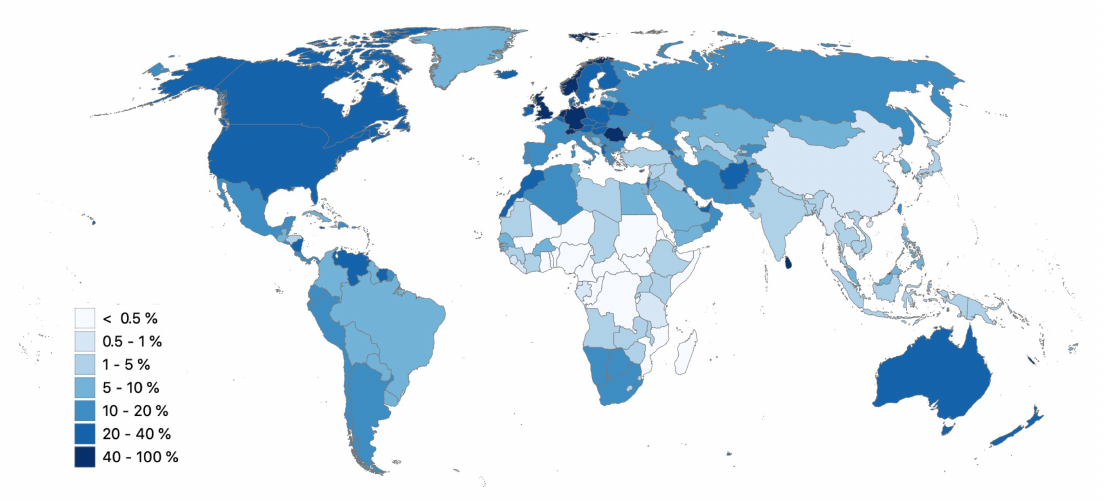
Figure 1. Proportion of the total length of all roads with maximum speed information in OpenStreetMap (OSM) ( maxspeed tag) per country (only road classes in Table 1). Only 7.4% of all road elements stored in the OSM world dataset released on October 2019 have information on maximum